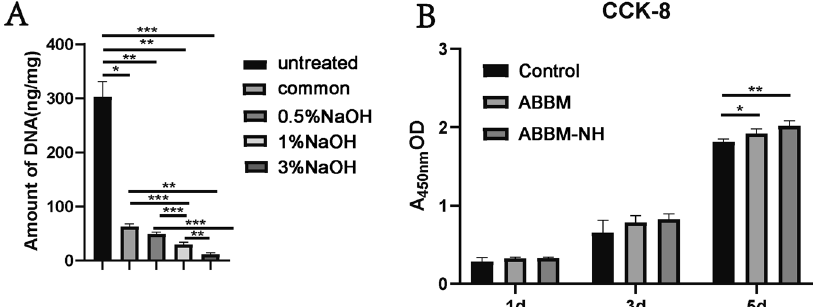
Fig. 2 Effect of BBM treated with NaOH. HE staining ( n = 5), ( A ) natural bovine bone matrix (NBBM); ( B ) acellular bovine bone matrix (ABBM); ( C ) ABBM treated by 1% NaOH (ABBM-1%NH).